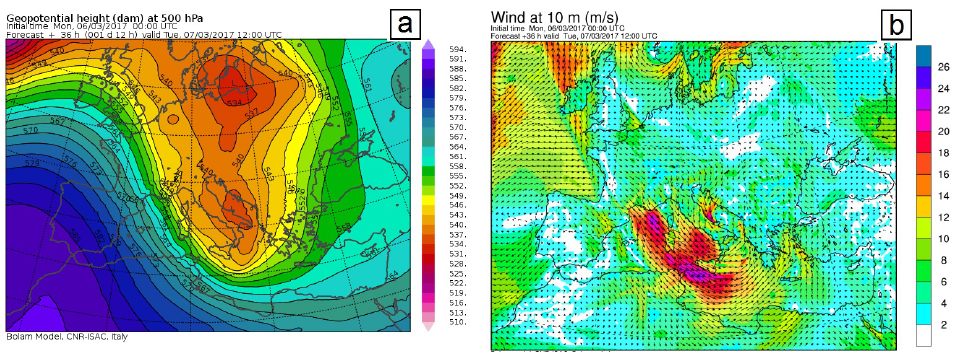
Figure 9. 7 March 2017 12:00 UTC: ( a ) Geopotential height (dam) at 500 hPa; ( b ) Wind (m/s) at 10 m (Bolam simulations).